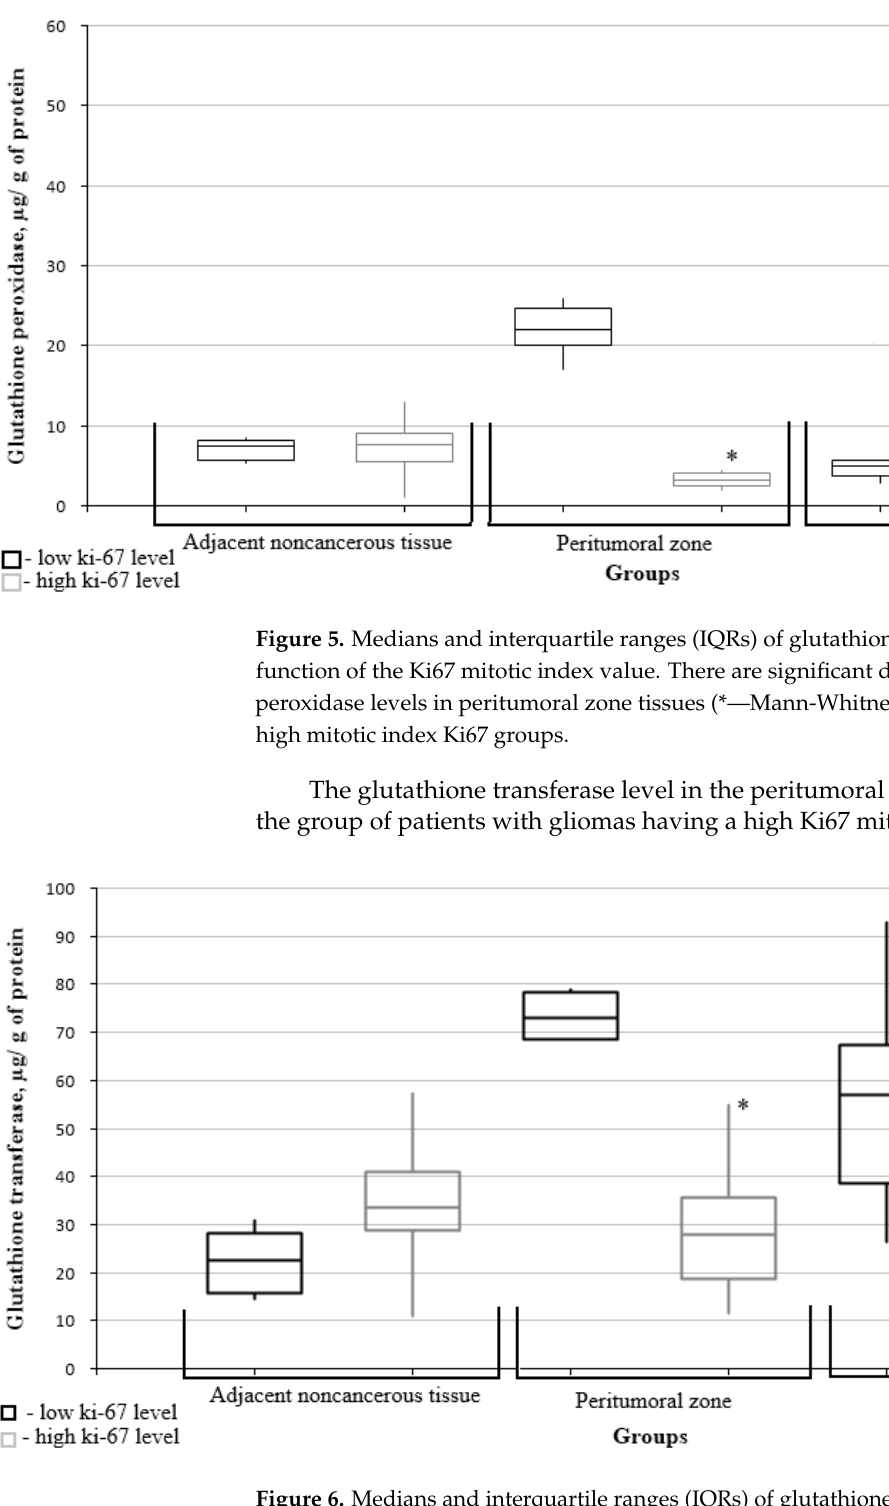
Figure 7. Medians and interquartile ranges (IQRs) of reduced glutathione levels in glial tumor tis- sues as a function of the IDH1 isocitrate dehydrogenase isoenzyme gene mutation. There are signif- icant differences between the tumor tissue reduced glutathione levels (* ̵ Mann-Whitney U-test p = 0.011) for groups with Wild type IDH1 and those expressing the IDH1 mutation. The levels of glutathione peroxidase in the peritumoral zone tissue of patients with gliomas and the IDH1 mutation were significantly higher than in the wild-type IDH1 group (Figure 8).